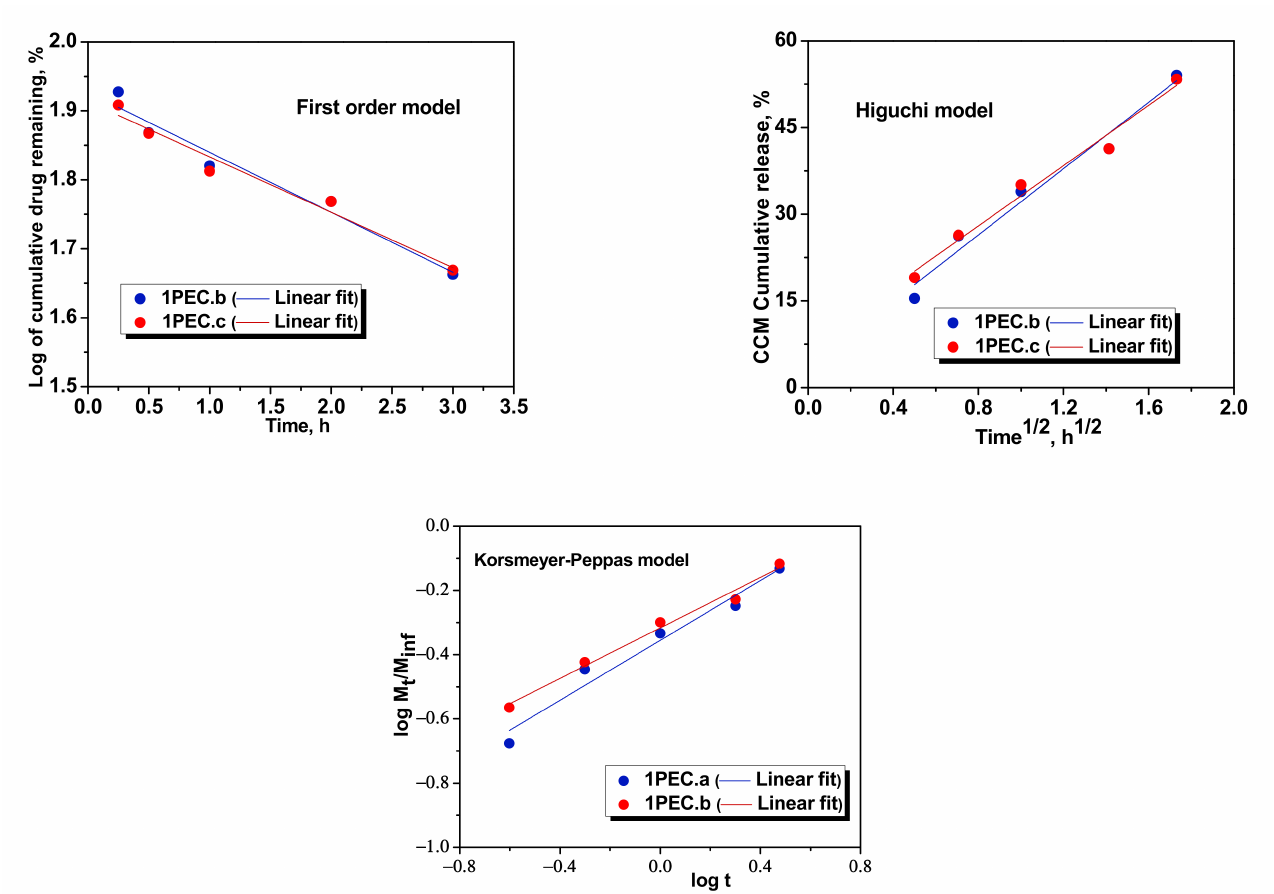
Figure 9. Fitting of kinetic models for the CCM release from 1PEC.b and 1PEC.c cryogels. The kinetic models were fitted also on the CCM release data from 2PEC.b and 2PEC.c cryogels, and the results are presented in Figure